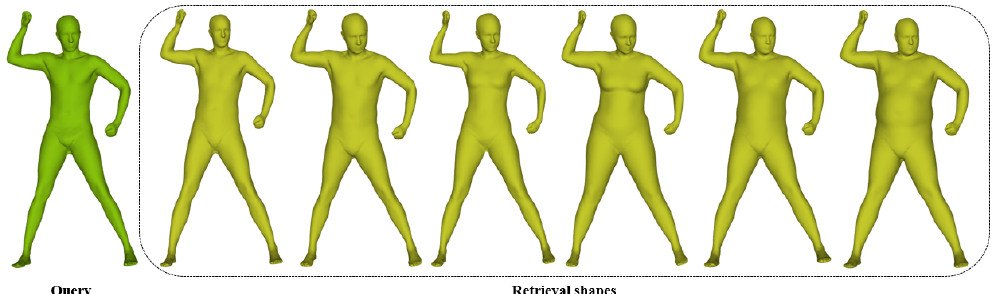
Figure 3. Pose retrieval: For the query 3D human shape (left one), our method retrieves the first six best shapes who have similar poses to that in the SHREC-RE dataset